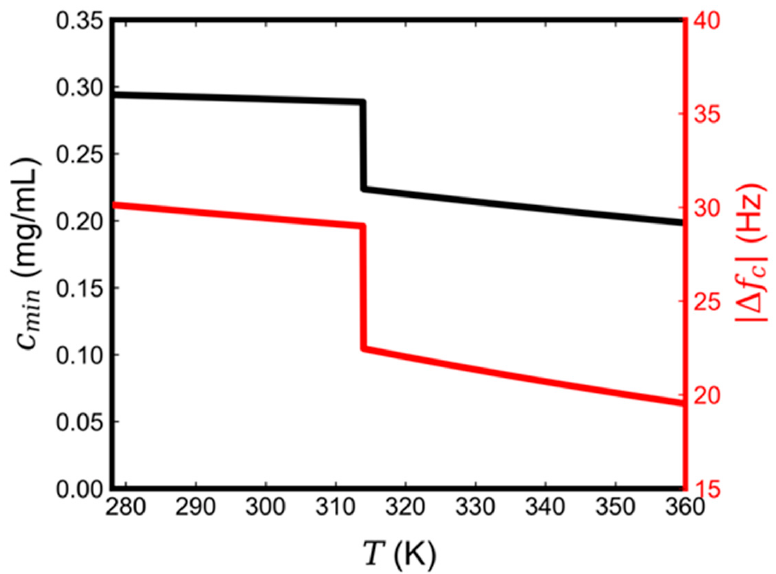
Figure 3. Effect of temperature during solvent exchange on the final frequency shift ( red ) and the minimum lipid concentration to form a complete DPPC SLB ( black ). The sudden drop is located at the phase transition temperature of DPPC, namely, T m = 314 𝐾 .